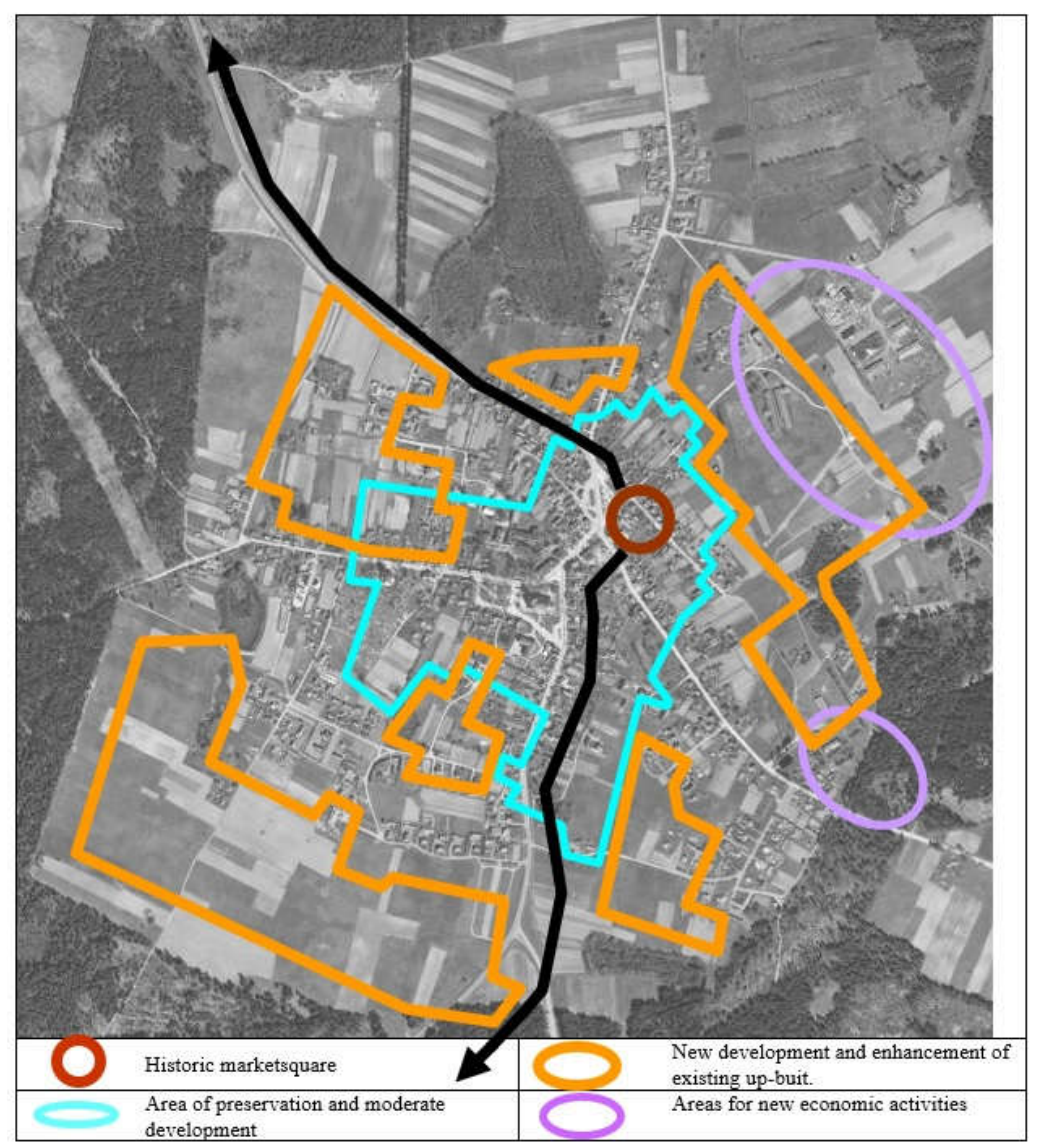
Figure 2. Land use map for future development of Šiluva. Raseiniai district municipality information. Red represents historic secular centre, yellow stands for future development boundaries, violet marks areas where new economic activities could be introduced into the township, and turquoise marks area of preservation concerns. Black line stands for main road crossing the township.